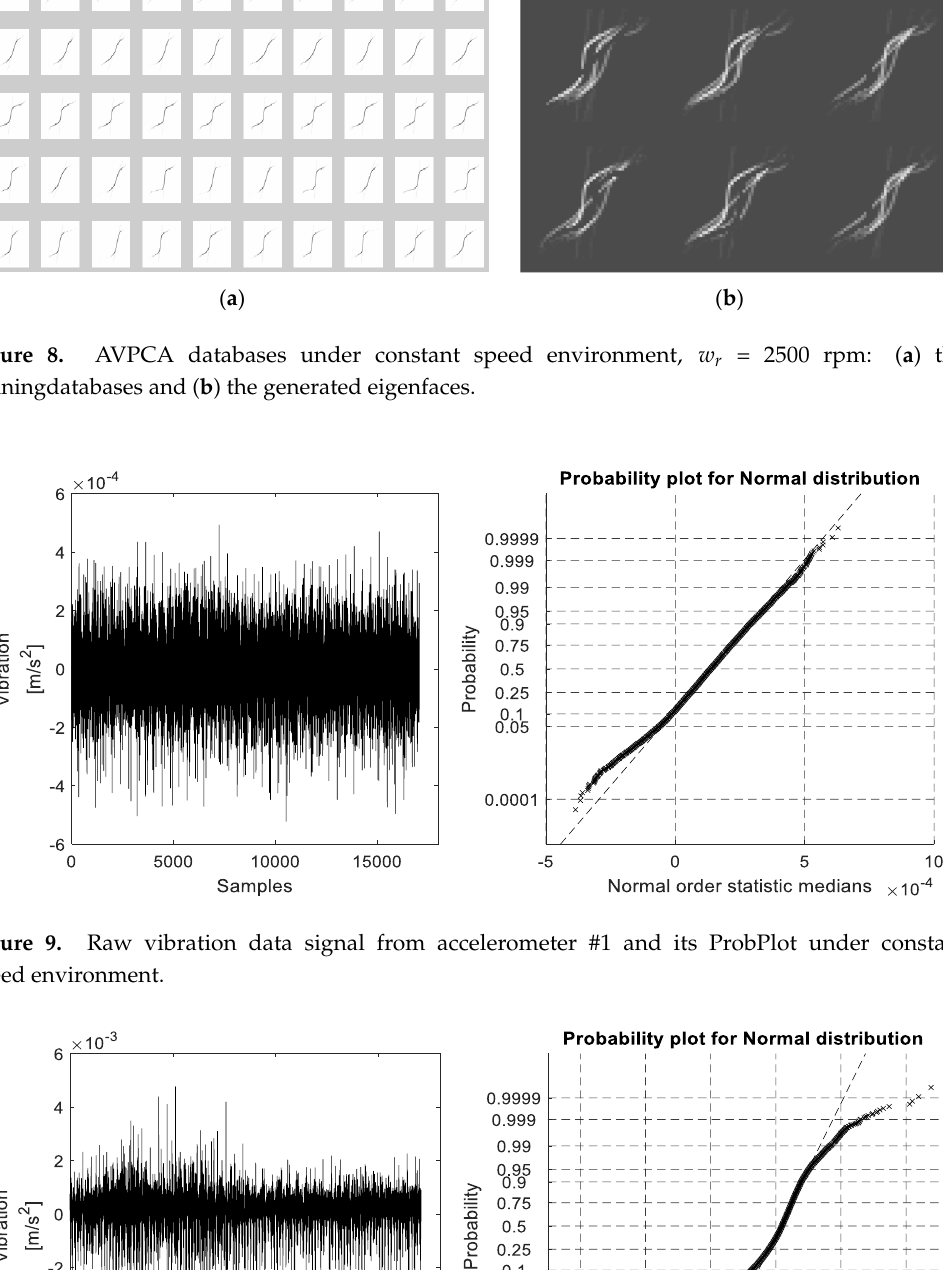
Figure 10. Raw vibration data signal from accelerometer #2 and its ProbPlot in bearing fault free (BFF) case under constant speed environment.